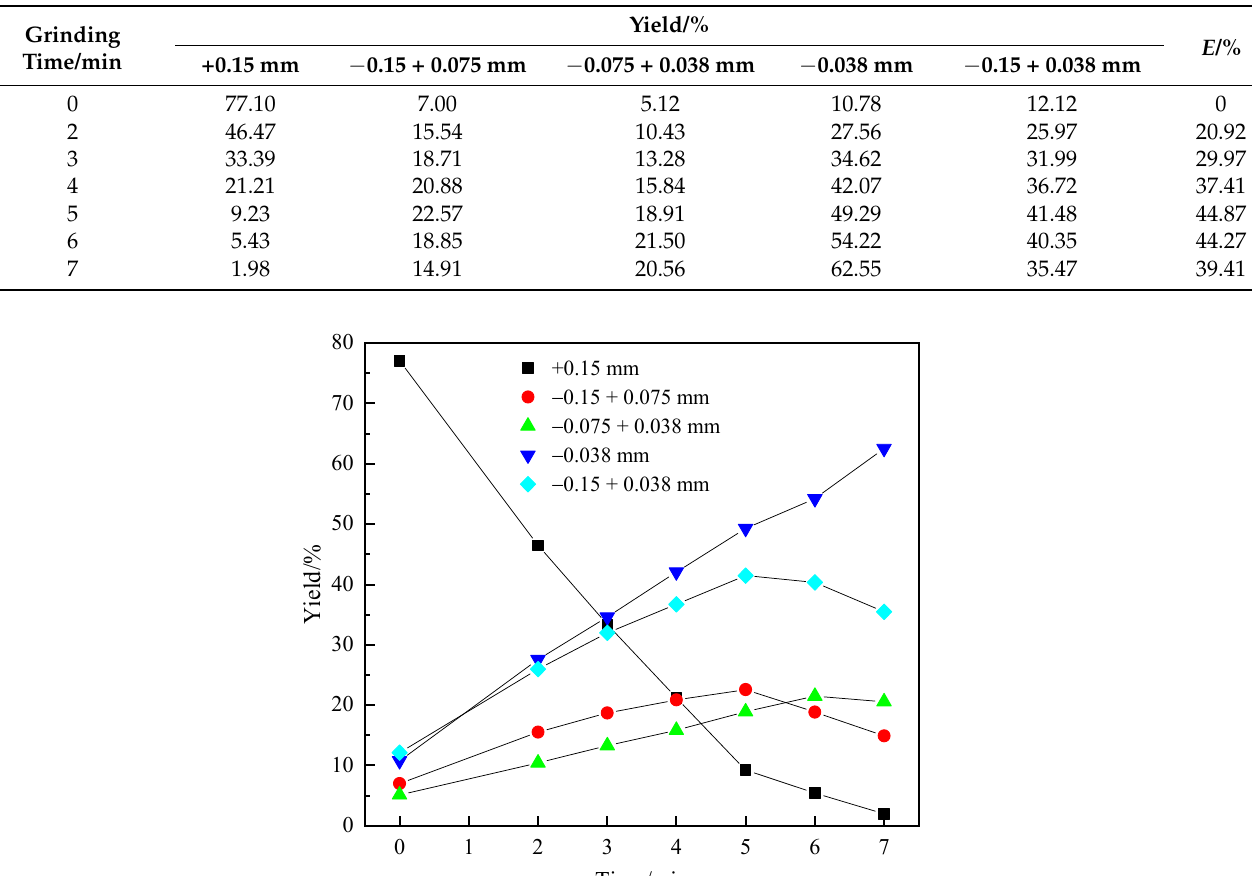
Table 4. Particle size composition of grinding product at different grinding times.